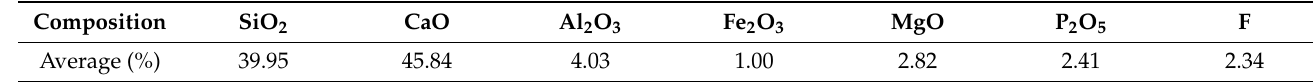
Table 5. Material composition of PSP.